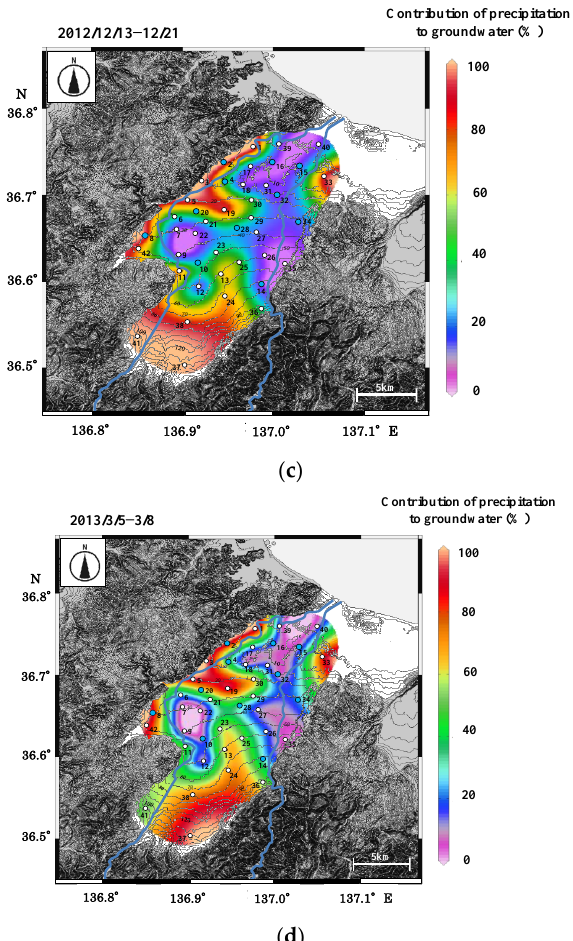
Figure 9. Contour maps of contribution of precipitation to groundwater in ( a ) 2012/4/24 – 5/1, ( b ) 2012/8/23 – 8/28, ( c ) 2012/12/13 – 12/21, and ( d ) 2013/3/5 – 5/8. In Figure 9b, a contour map in August